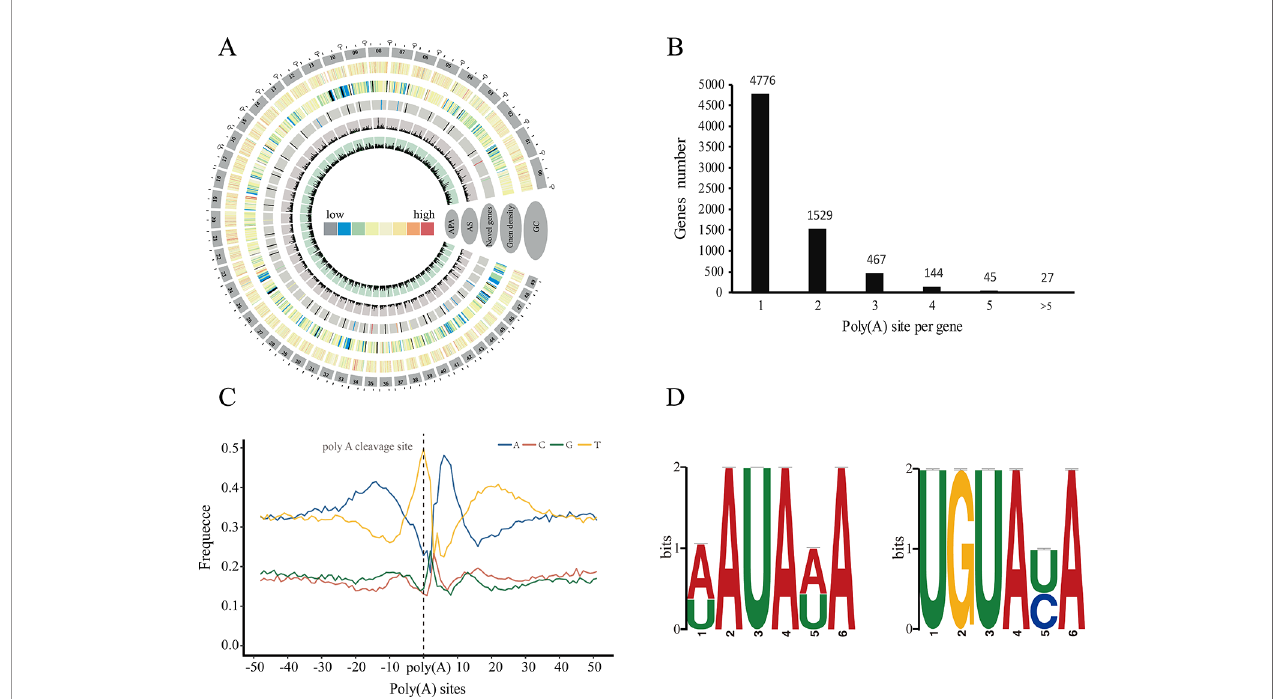
FIGURE 2 | Characteristics of alternative polyadenylation (APA) in Populus alba var. pyramidalis . (A) Concentric circles diagram illustrating the genome-wide pro fi le of novel genes, alternative splicing (AS) and alternative polyadenylation (APA). The largest 50 scaffolds are plotted at the outer circles. From the outer edge to inner circles display guanine-cytosine (GC) content, gene density, novel genes with supported PacBio-isoform number, AS and APA, respectively. (B) Distribution of the number of poly (A) sites per gene. (C) nucleotide composition around poly (A) cleavage sites. (D) MEME-CHIP analysis identi fi ed a poly (A) signal in Populus alba var. pyramidalis transcripts. Left, an over-represented motif about 30 nts upstream of the poly (A) site similar to the known signal in dicots was identi fi ed. Right, another overrepresented motif (UGUAUA) is found about 50 nts upstream of the poly (A)